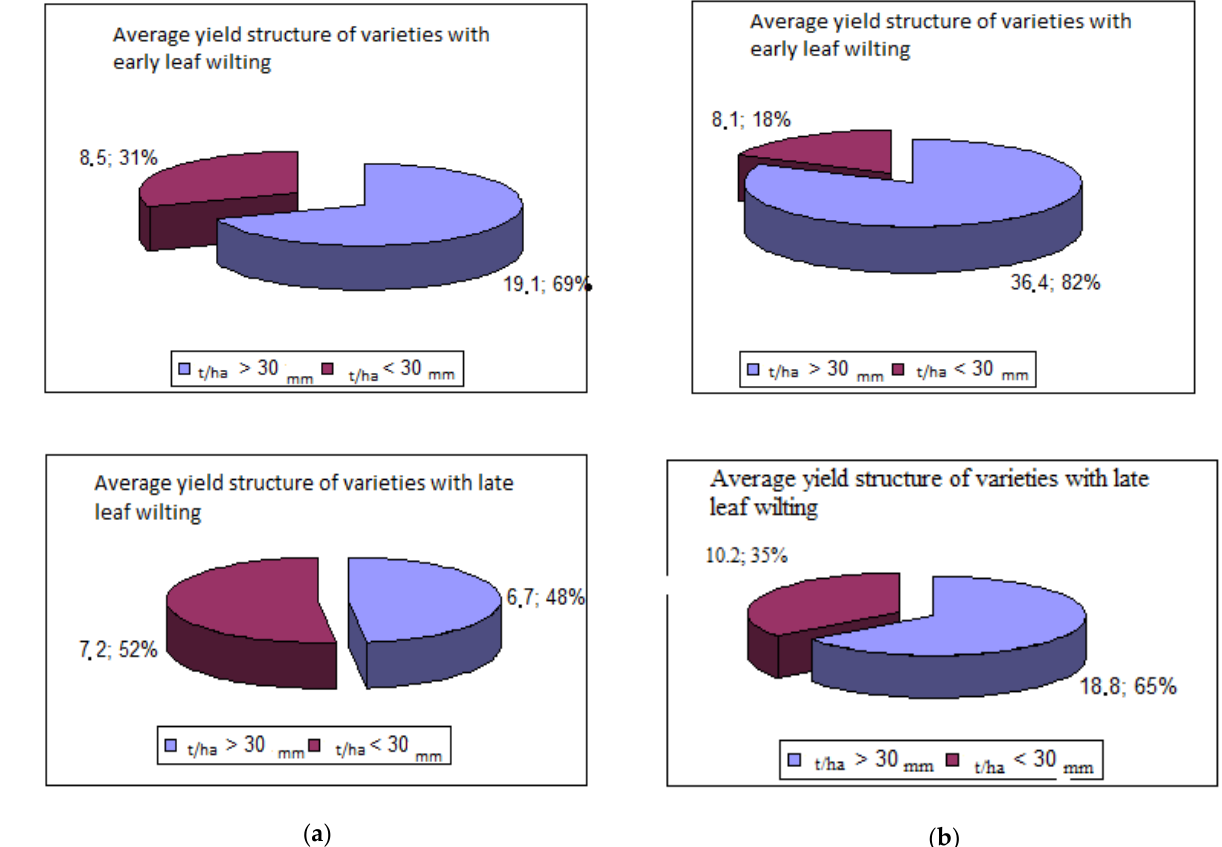
Figure 2. Yield structure of tubers according to leaf wilting groups. ( a ) Harvesting in late August – early September; ( b ) harvesting in the third ten-day period of October.